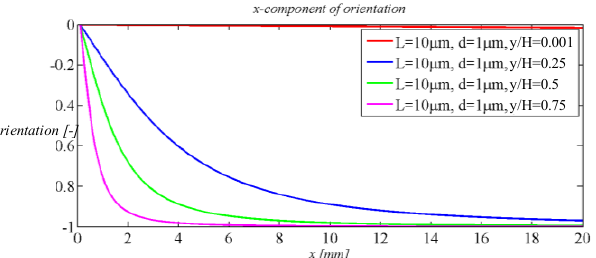
Fig. 4. Streamwise component of fibre orientation along the travelled distance